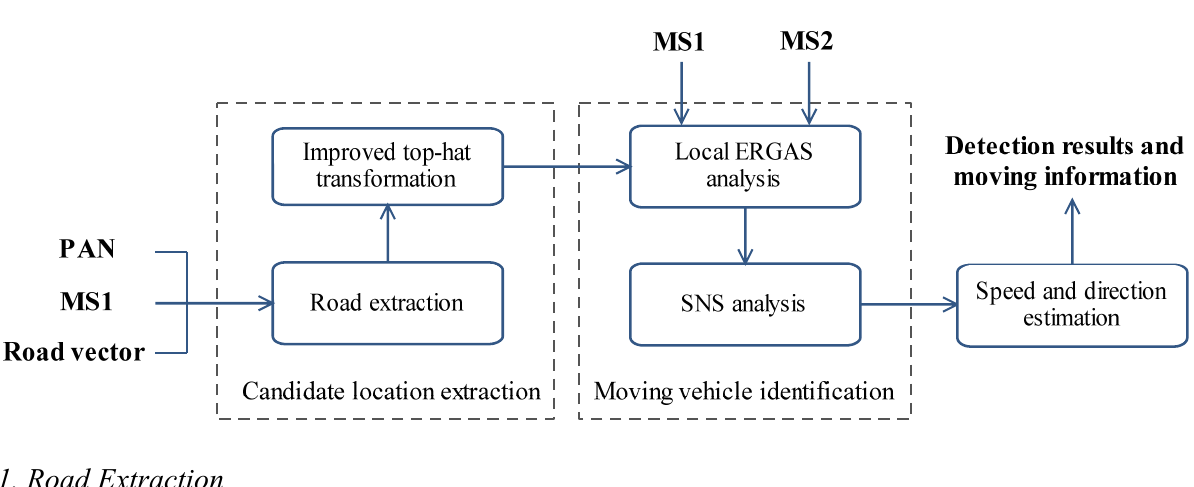
Figure 1. Flow diagram of the proposed method.